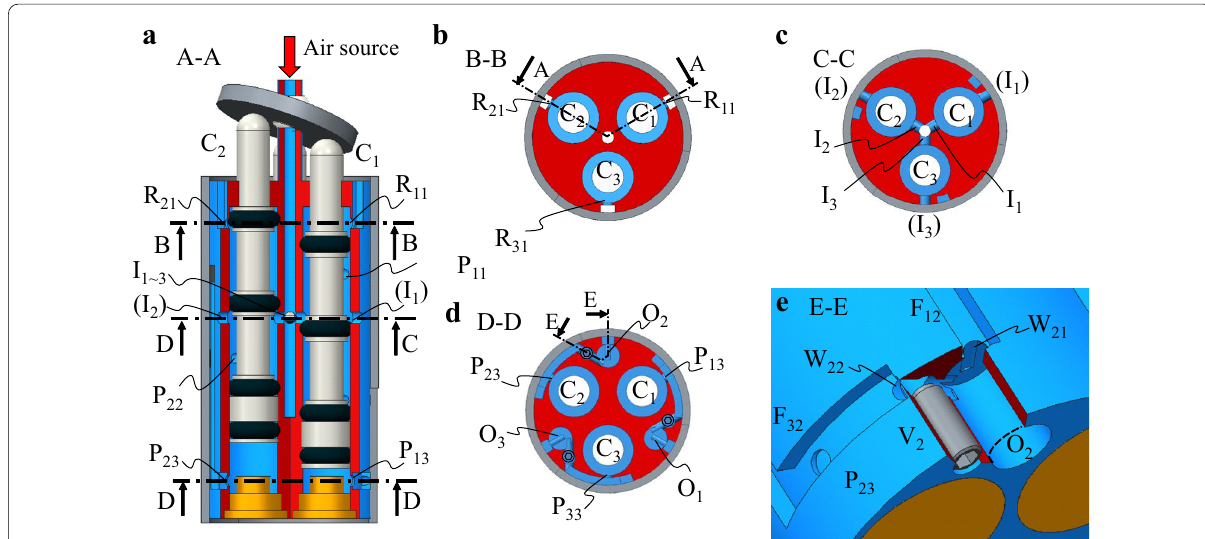
Fig. 8 Cross-sections of the main part. a Cylinders and plungers. b Cross section at the relief ports. c Cross section at the input ports. d Cross section to show the connection of the flow channels at output ports. e Cutaway image of output port to show the fitted throttle